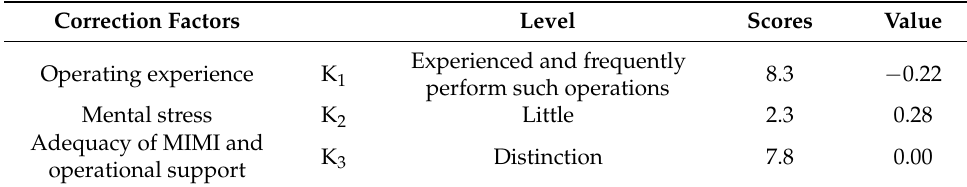
Table 12. Questionnaire summary of HCR correction factor after layout